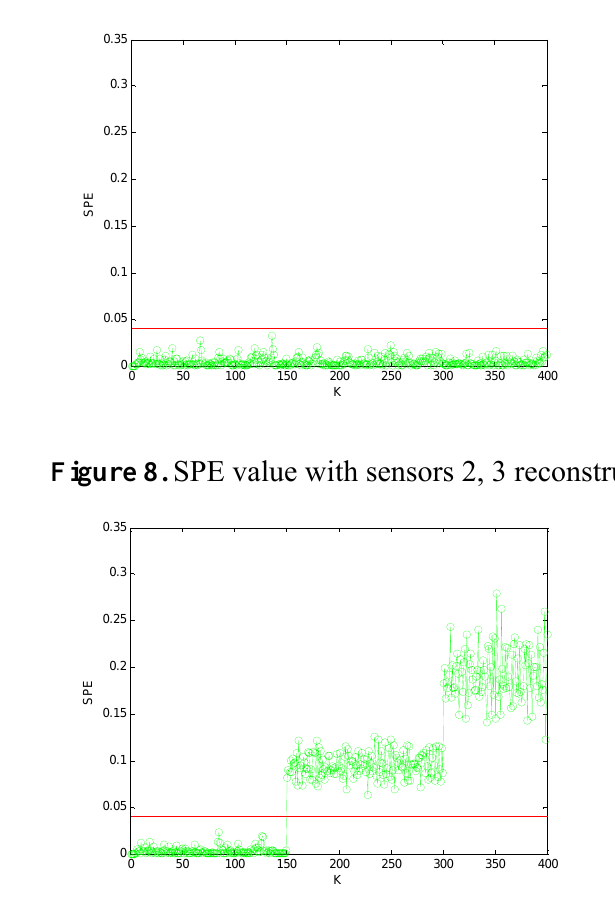
Figure 7. SPE value with the sensors 1, 4 reconstructed.